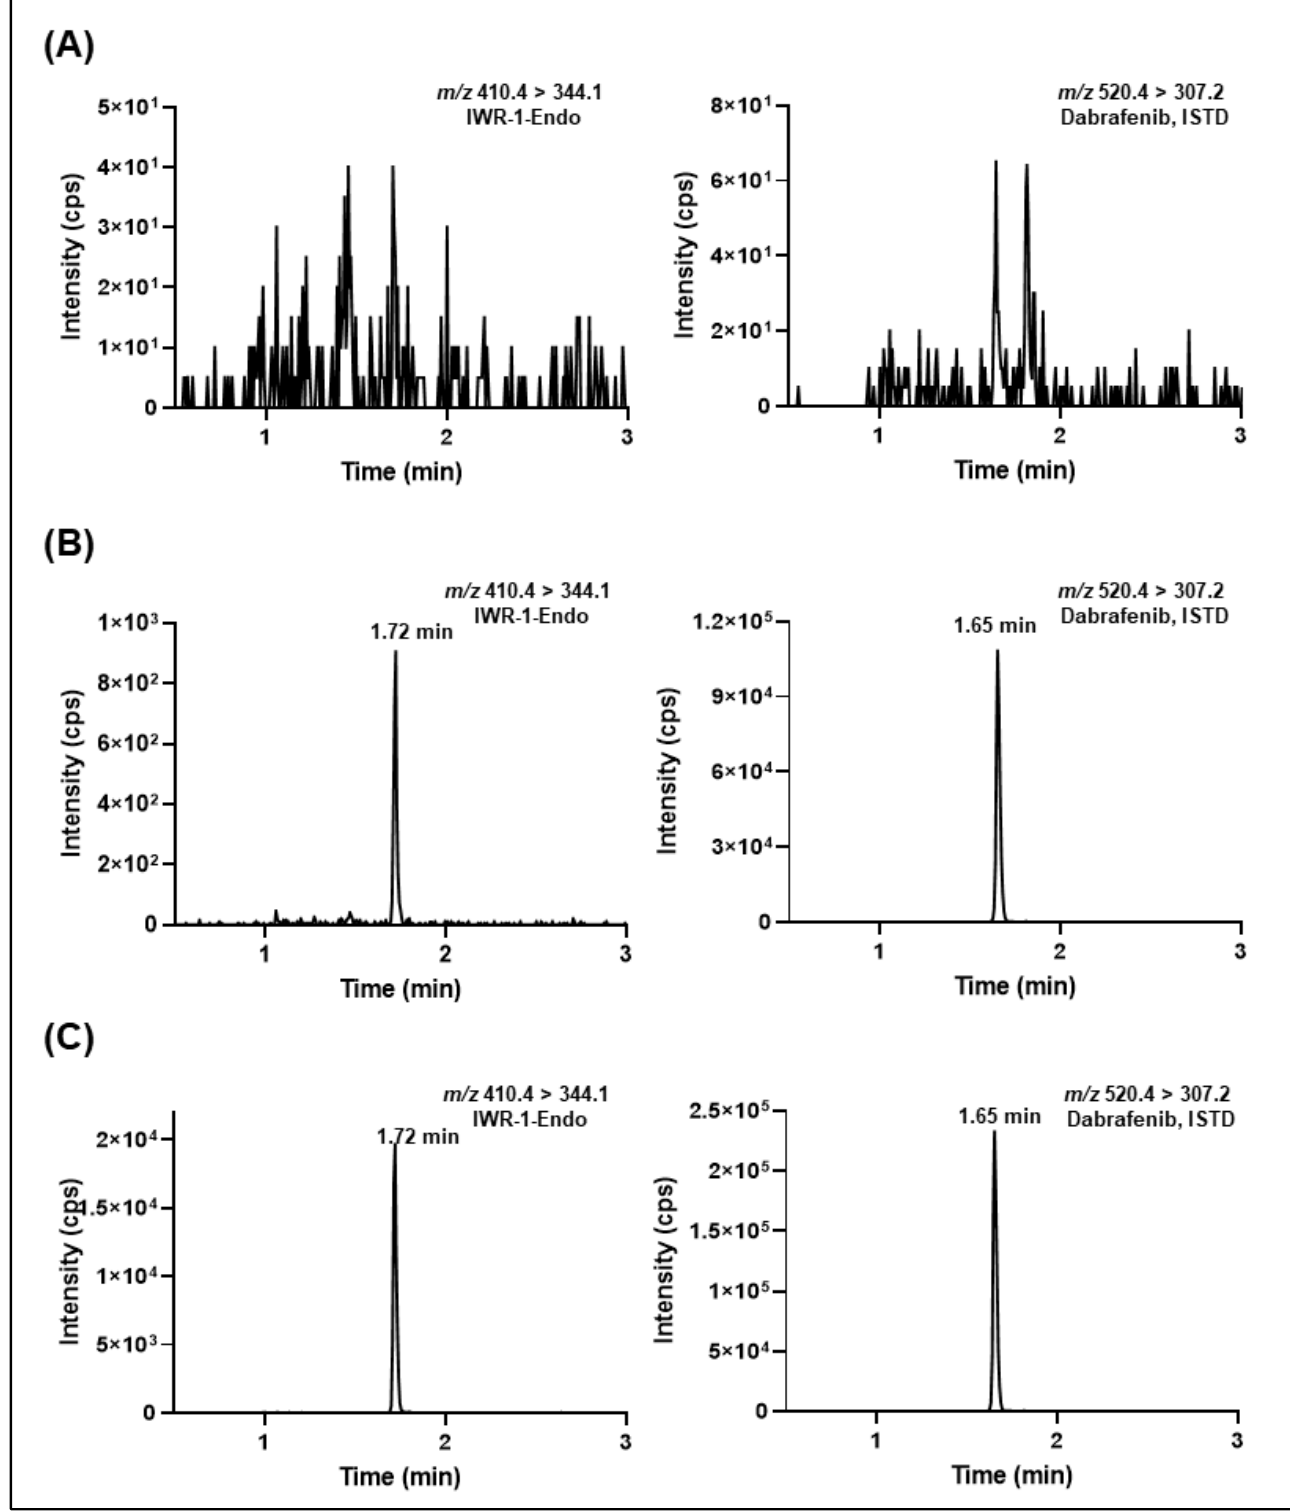
Figure 6. Representative extracted-ion chromatograms of ( A ) microdialysate blank, ( B ) IWR-1-endo- spiked microdialysate sample at LLOQ (0.5 ng/mL) with ISTD added, and ( C ) 1 h plasma sample from the microdialysis study (ISTD added) after administration of 30 mg/kg IWR-1-endo intraperi- toneally.